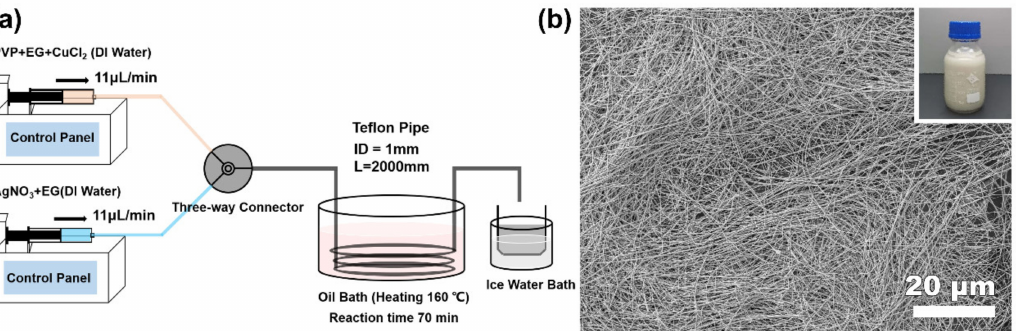
Figure 1. ( a ) Schematic illustration of a single-channel continuous-flow reactor for scalable production of Ag NWs. ( b ) Representative SEM image of Ag NWs obtained by such a continuous-flow